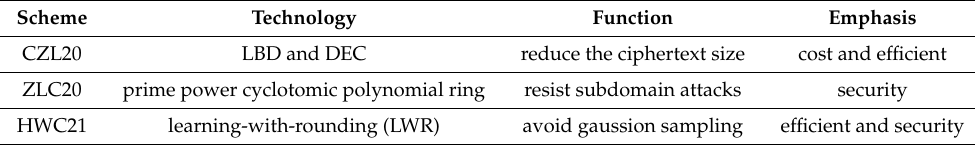
Table 1. Summary of Section